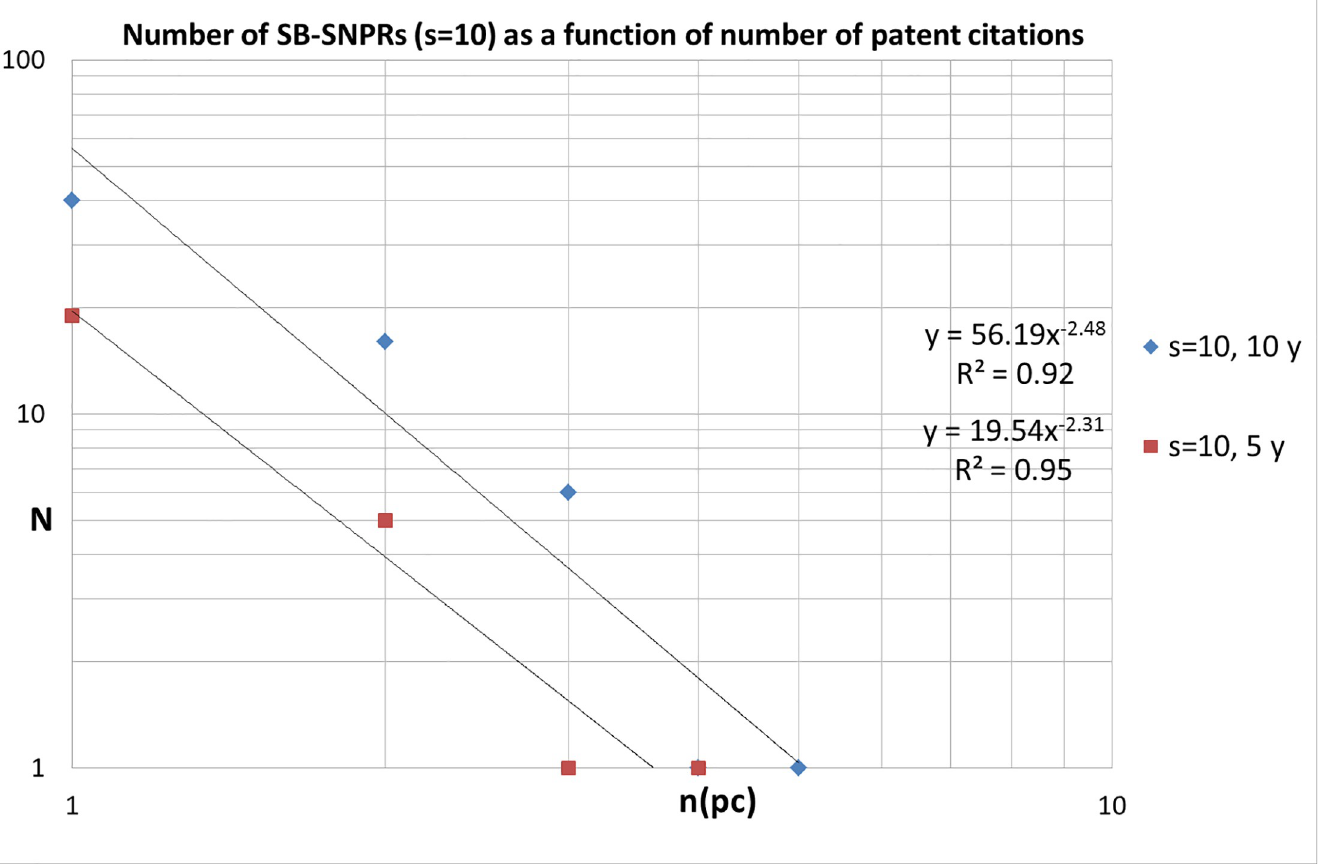
Fig 13. Number of SBs with s = 10 cited by patents as a function of number of patent citations n(pc), citation windows 5 and 10 year.